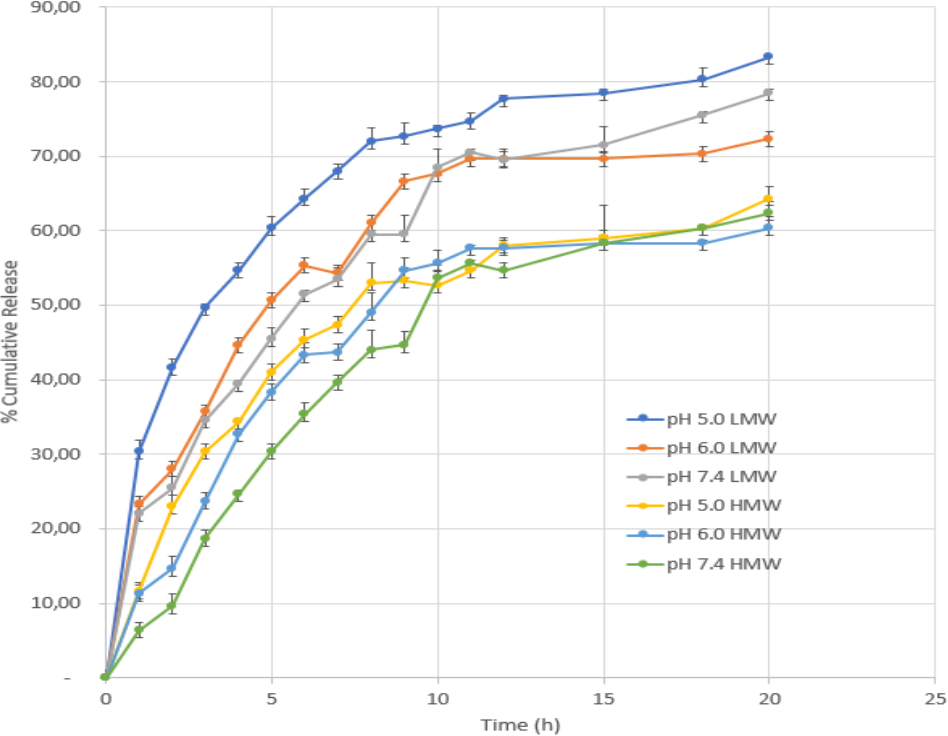
Figure 6. In vitro drug release profiles from CSNPs.